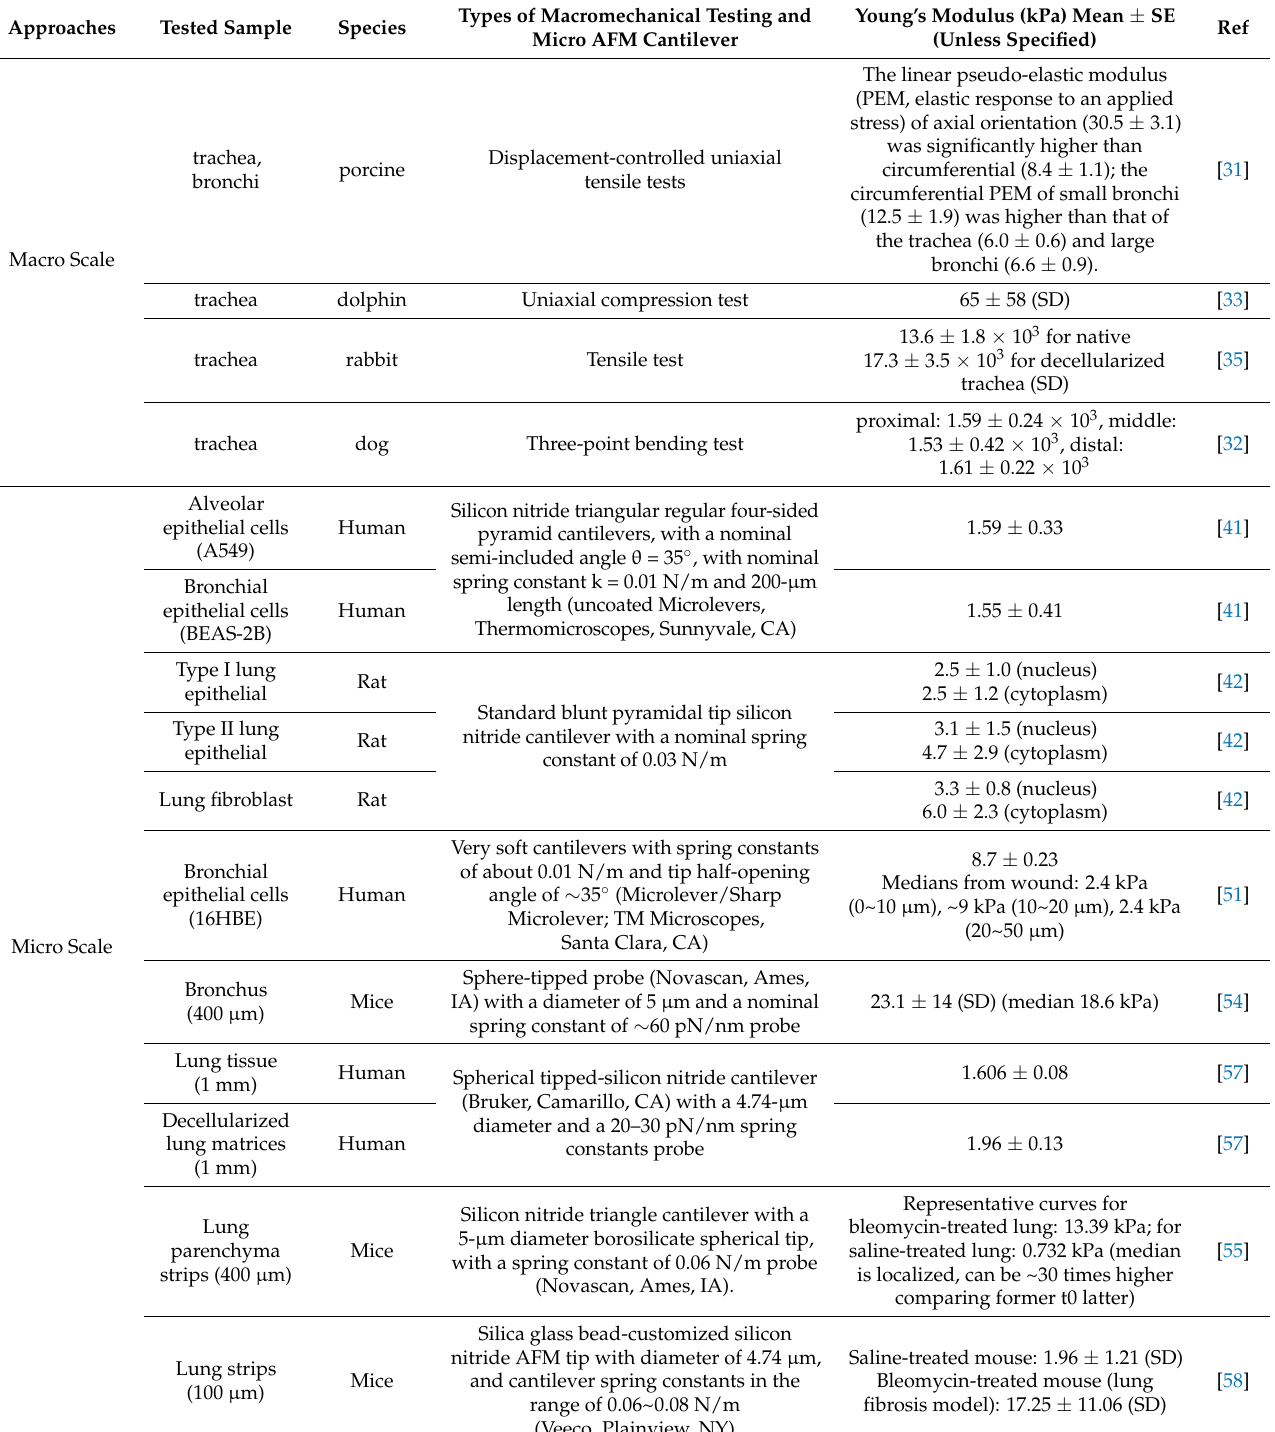
Table 2. Young’s modulus of macro and micro quantification of airway cells, ECM, and tissue. AFM: atomic force